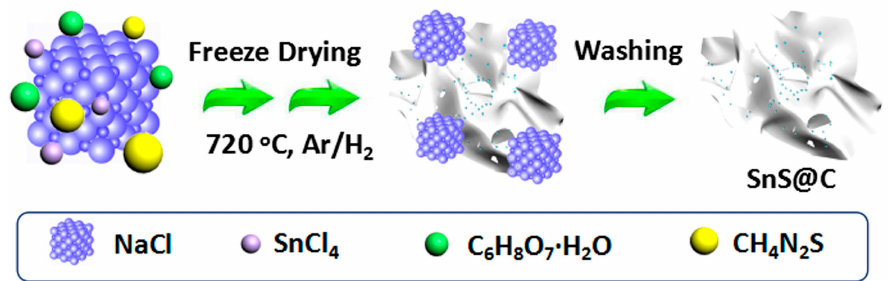
Figure 1. Schematic illustration of preparation process of SnS decorated carbon nano-networks (SnS@C) composites.